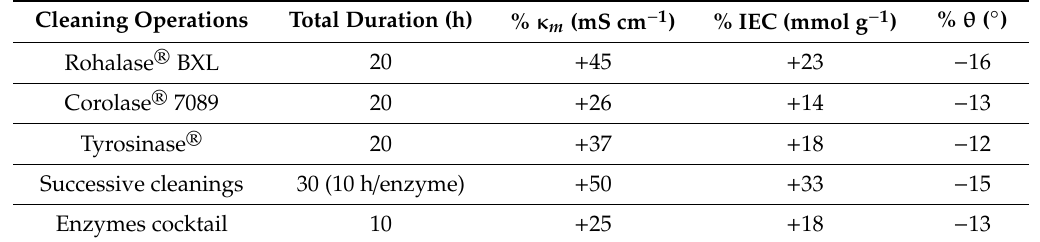
Table 2. Summary of the recovery rates of κ m , IEC, and θ after the di ff erent enzymatic cleanings. Cleaning